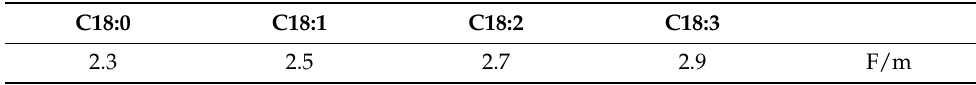
Table 3. Dielectric constant * of octadecanoic fatty